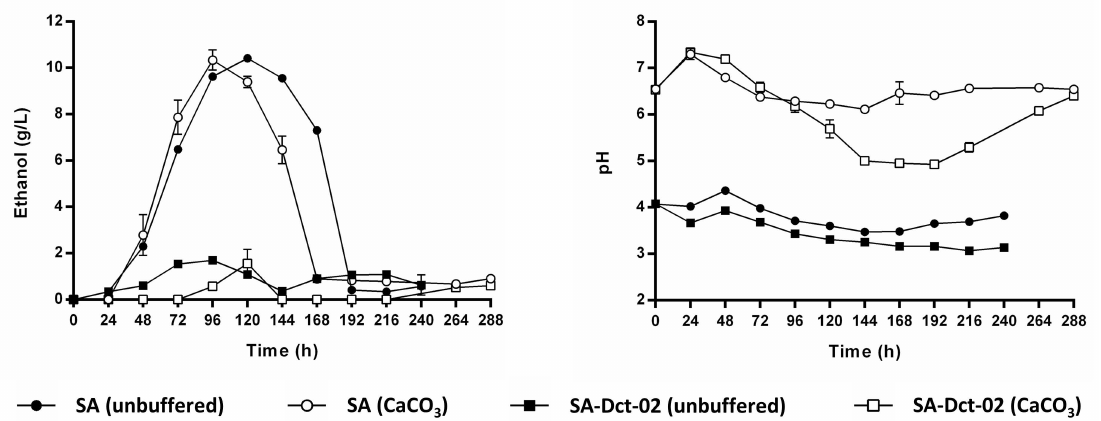
Figure 2. Saccharomyces cerevisiae strains SA ( • and ) and SA-Dct-02 ( (cid:4) and (cid:3) ) cultivated in (cid:35) unbuffered ( • and (cid:4) ) and CaCO 3 -buffered ( and (cid:3) ) synthetic glycerol media (see composition in (cid:35) materials and methods). The cultivations were performed in 500 mL shake flasks filled with 100 mL medium using urea as the nitrogen source. The unbuffered medium had an initial pH of 4.0. The buffered medium had an initial pH of 6.0 prior to the addition of 30 g/L of CaCO 3 . An HPLC analysis was used to determine the concentrations of succinic acid, malic acid, glycerol, and ethanol in the culture supernatants. Biomass accumulation was measured by optical density at 600 nm (OD 600 ). Mean values and standard deviations were determined from three biological